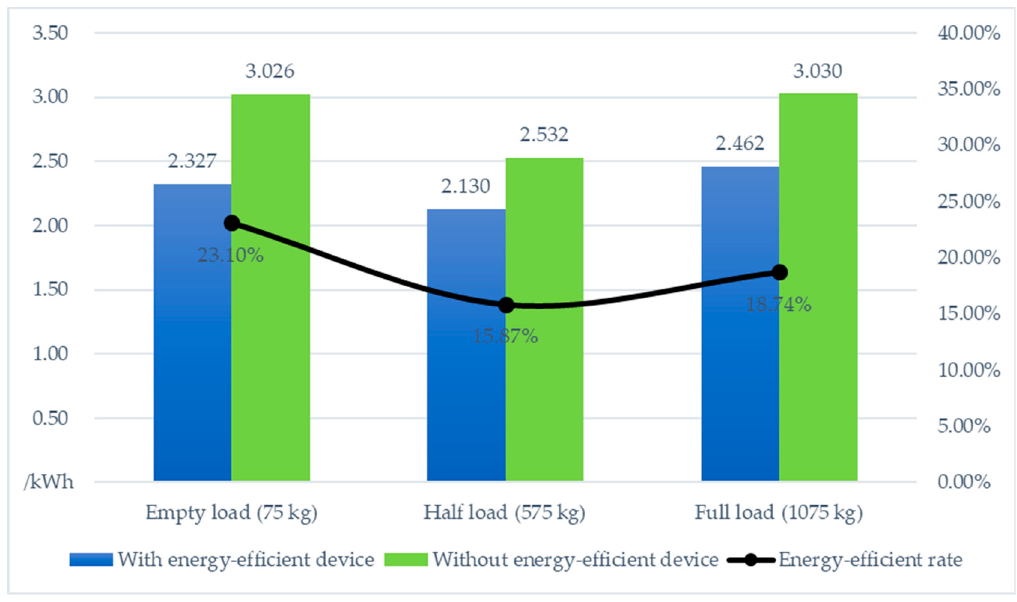
Figure 9. The energy consumption and energy-efficient rate in the experiment [47].